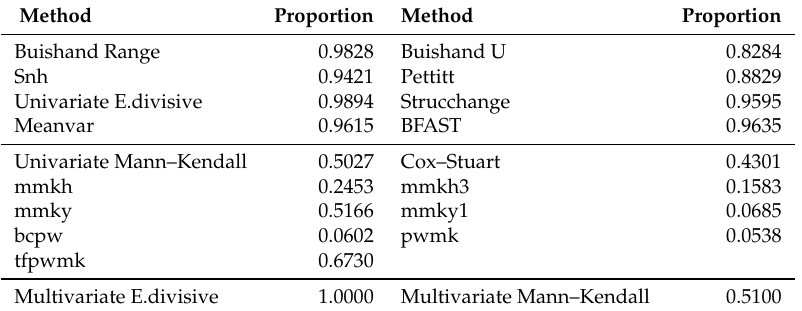
Table 3. Mean type I error probability based on 100 simulations of multi-layer rasters under the second scenario, wherein pixel time series are generated from an autoregressive model with parameter